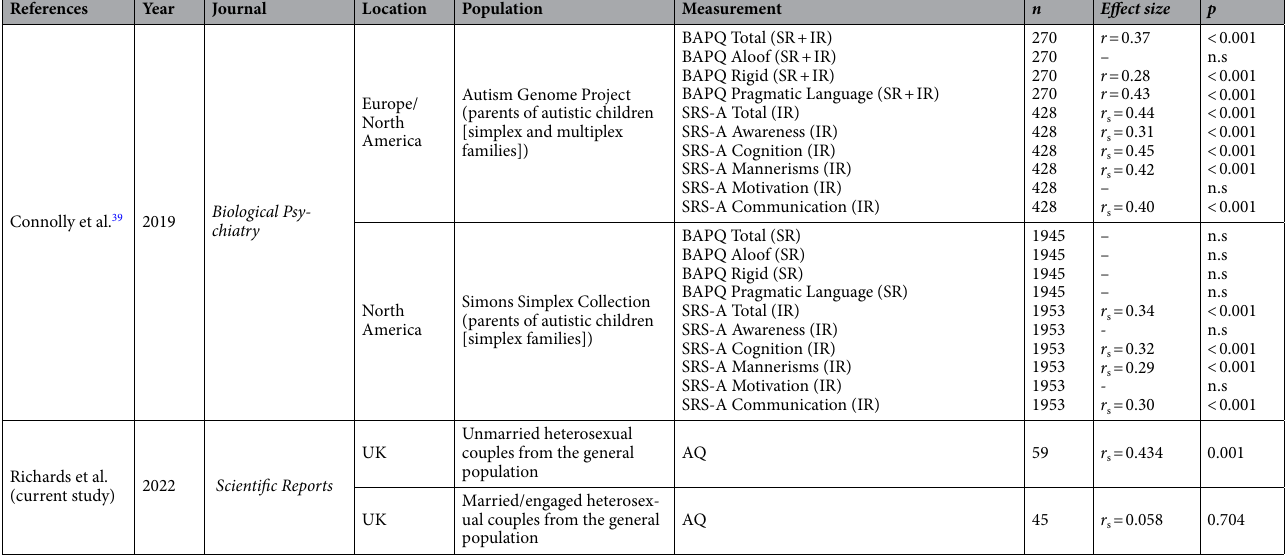
Table 4. Overview of studies included in the meta-analysis of within-couple correlations for autistic traits. AQ, Autism Spectrum Quotient; BAPQ, Broad Autism Phenotype Questionnaire; SRS, Social Responsiveness Scale. *The two samples of Lyall et al. were analysed together; n = 1198 couples were included, though it is unclear how many were parents of autistic children and how many were control